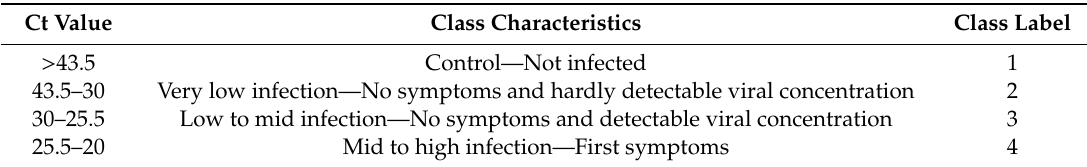
Table 2. Class division of tomato plants into healthy (control) and three disease severity stages according to their cycle threshold (Ct) value.